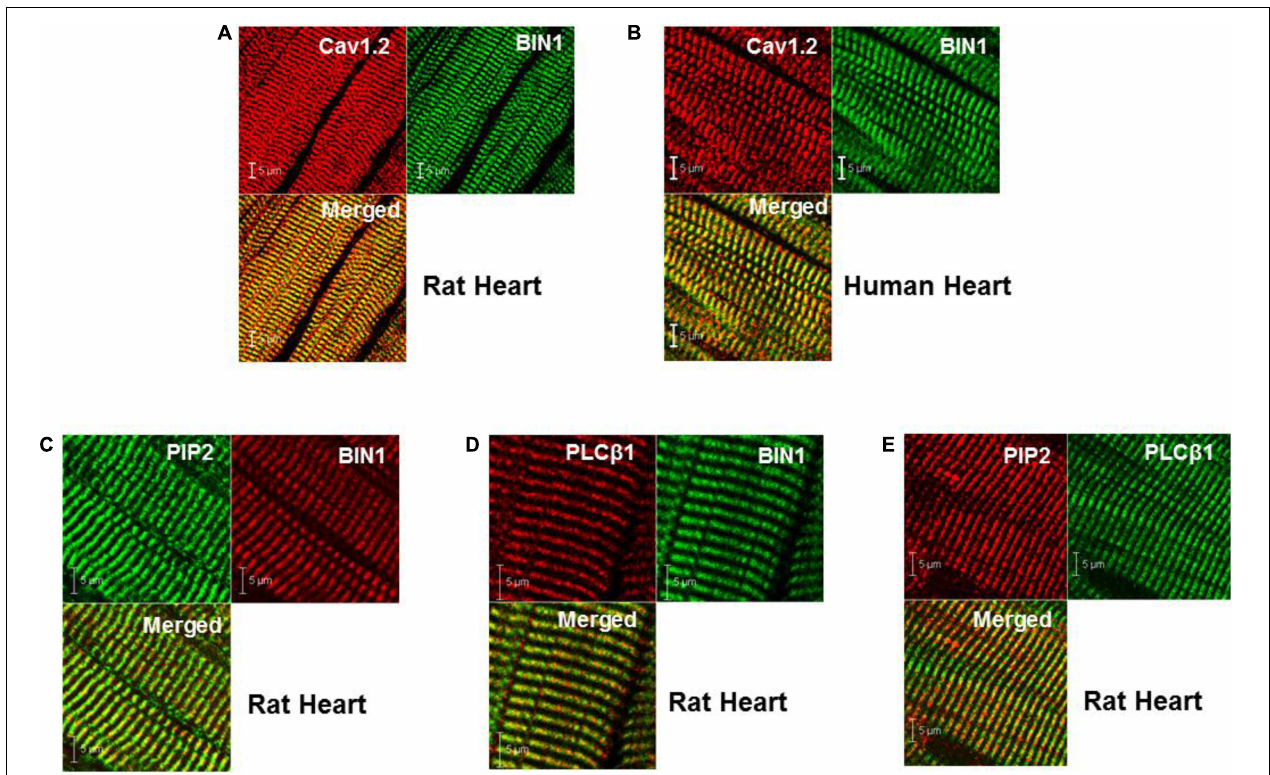
FIGURE 1 | Cellular localization of BIN1, PIP2, and PLC β 1 at TTs in both rat and human heart. (A,B) Co-localization of BIN1 with Cav1.2 in rat and human ventricle. (C–E) PIP2 and PLC β 1 are also localized at t-tubules in rat heart. Pixel size was 0.02–0.04 µ m/pixel and all images were obtained with the pinhole adjusted to Airey units = 1.